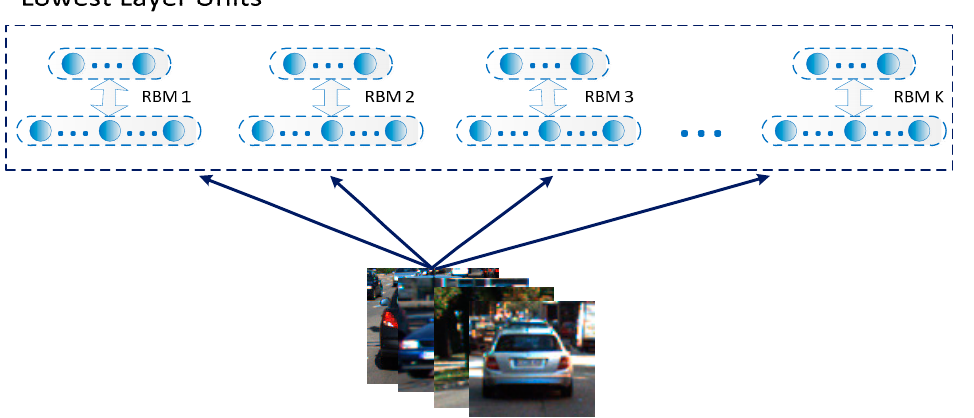
Figure 3. Design of lower-layer units in the designed deep model.